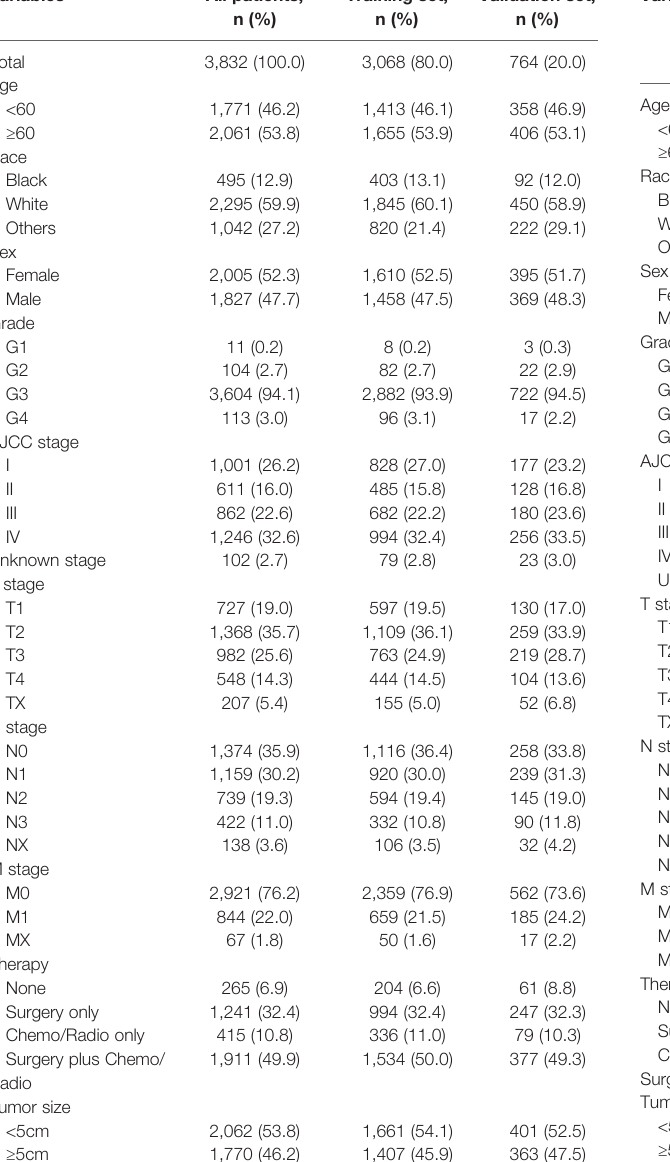
TABLE 1 | Baseline clinicopathological characteristics and treatment regimens of patients.